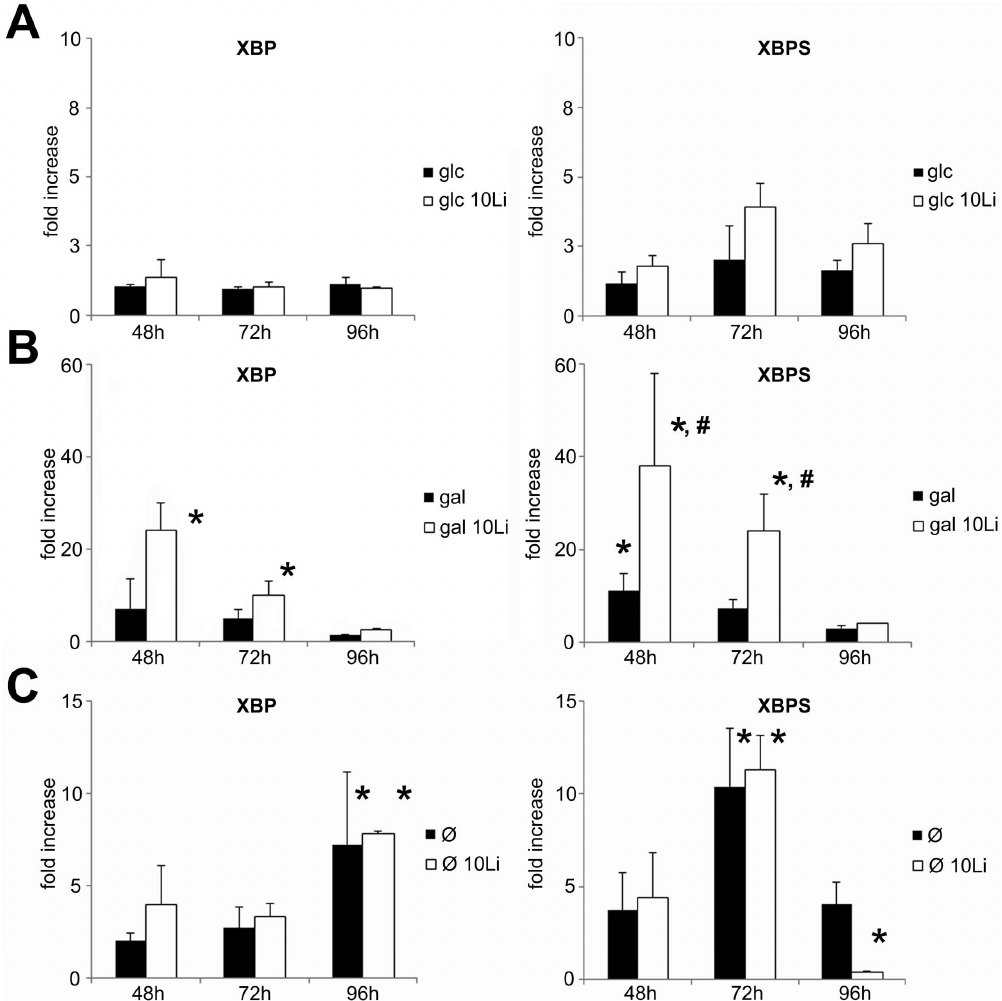
Figure 5. UPR is greatly activated in Jurkat cells grown on galactose and treated with lithium. Jurkat cells were incubated in 5 mM glucose or 5 mM galactose containing or hexose-free media for 48, 72 or 96 hours, with or without 10 mM lithium. UPR activation was assessed by the increase of X-box binding protein 1 (XBP) and XBP transcript variant 2 (XBPS) mRNA expressional level. Each bar represent fold increase of relative levels of XBP or XBPS mRNA compared to control (5 mM glc treated for 48 hours) samples. ( A ) Relative levels of XBP and XBPS mRNA in glucose or glucose + lithium treated cells at the indicated treatment times. ( B ) Relative levels of XBP and XBPS mRNA in galactose or galactose + lithium treated cells. ( C ) Relative levels of XBP and XBPS mRNA in fasting or fasting + lithium treated cells. Data are means 6 SD from at least 4 independent experiments. *P , 0.05 vs. glucose treated cells at the corresponding treatment times, # P , 0.05 vs. gal at the corresponding treatment times.